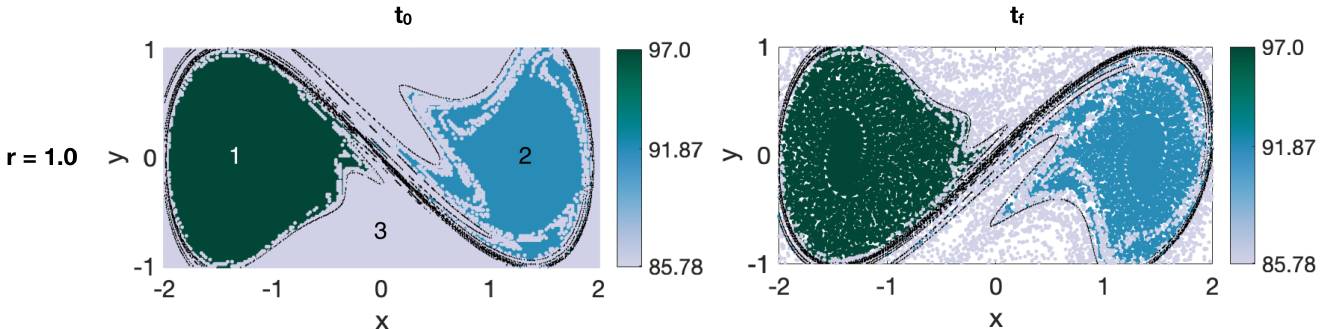
Figure 5. Coherent clusters, color-coded by their coherence metrics, resulting from the optimized-parameter spectral clustering for the asymmetric Duffing oscillator flow. The initial ( t 0 — left ) and final ( t f — right ) positions are shown. For comparison, black curves show the FTLE ridges in forward-time at t 0 and in backward time at t f . The spectral clustering was done for 30T pert ; FTLE ridges were computed for 10T pert